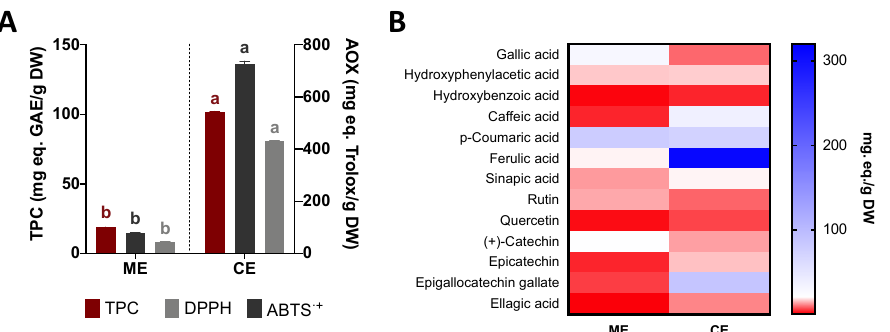
Figure 1. Polyphenolic composition of common mullein ( V. thapsus ) (ME) and castor bean (R. commu- nis ) (CE) extracts. ( A ) Content of total phenolic compounds (TPC) and antioxidant capacity (AOX), measured by ABTS and DPPH methods of V. thapsus (ME) and R. communis (CE) extracts. ( B ) In- dividual phenolic compounds identified by HPLC-DAD for ME and CE extracts. The results were expressed as the mean ± SD of three independent experiments in triplicates. Different letters in ( A ) (a, b) represent significant differences by Student’s t -test ( p < 0.05) between ME and CE. Castor bean ethanolic extracts also yielded a higher TPC (Figure 1A) than reported values for methanolic and aqueous extracts of castor bean leaves (~30–50 mg GAE/g DW) [15]. The values are significantly lower than TPC contents from five R. communis Tunisian populations (174.25–623.7 mg GAE/g DW) [37]. However, the authors